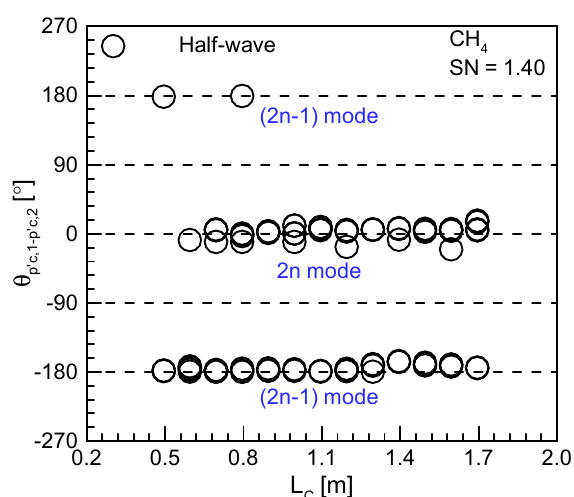
Figure 12. Phase difference ( θ p (cid:48) at SN = 1.40.